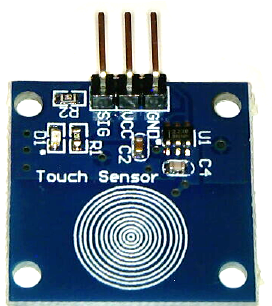
Figure 4. Capacitive touch